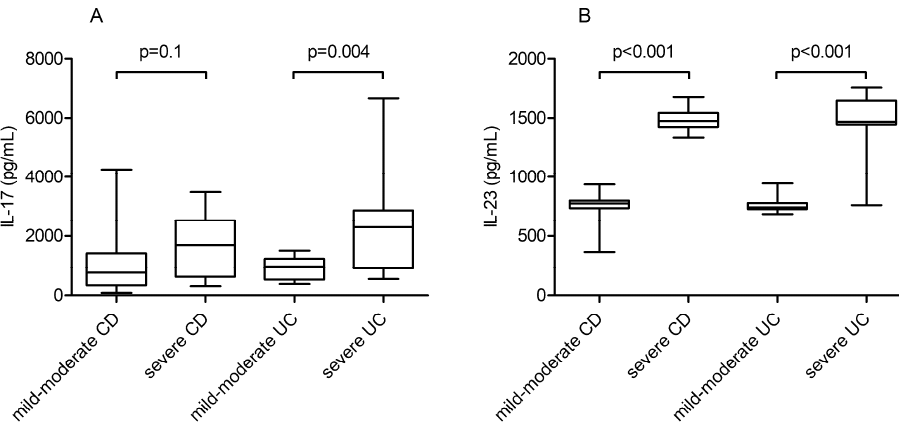
Figure 3. IL-17 and IL-23 quantitative serum level distribution in IBD patients according to disease severity: ( A ) IL-17 serum levels in mild-moderate vs. severe CD groups and mild-moderate vs. severe UC groups. ( B ) IL-23 serum levels in mild-moderate vs. severe CD groups and mild-moderate vs. severe UC groups.